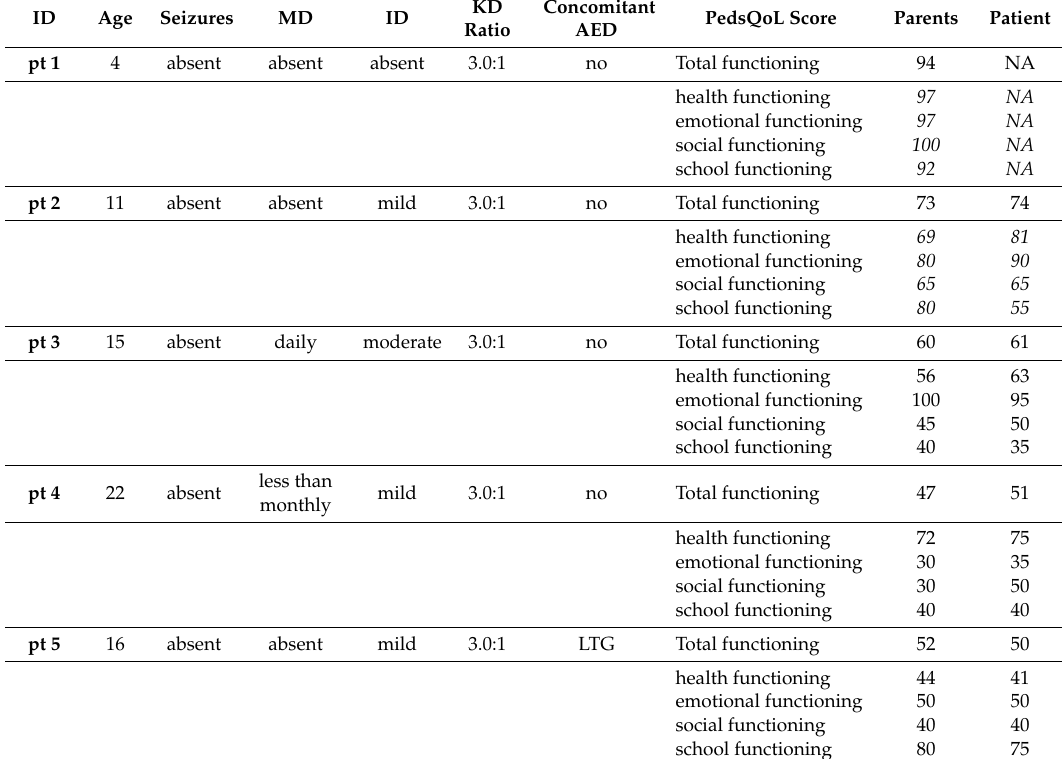
Table 1. Main characteristics of the study